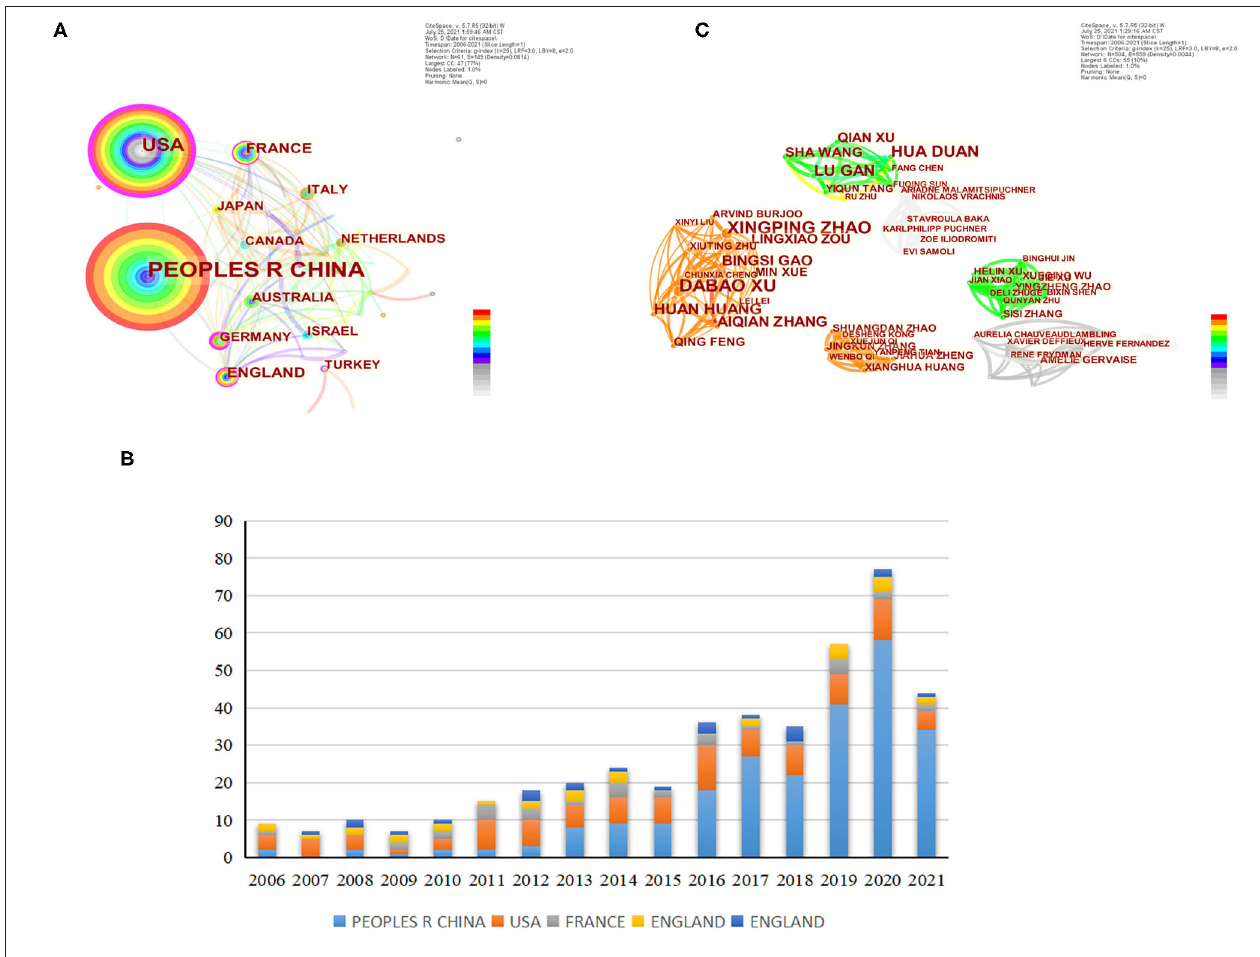
FIGURE 3 | The visual images of countries and institutions generated by CiteSpace software. (A) The visual images of countries. (B) Annual circulation of the top 5 countries with total circulation from 2006 to 2021. (C) The visual images of authors.